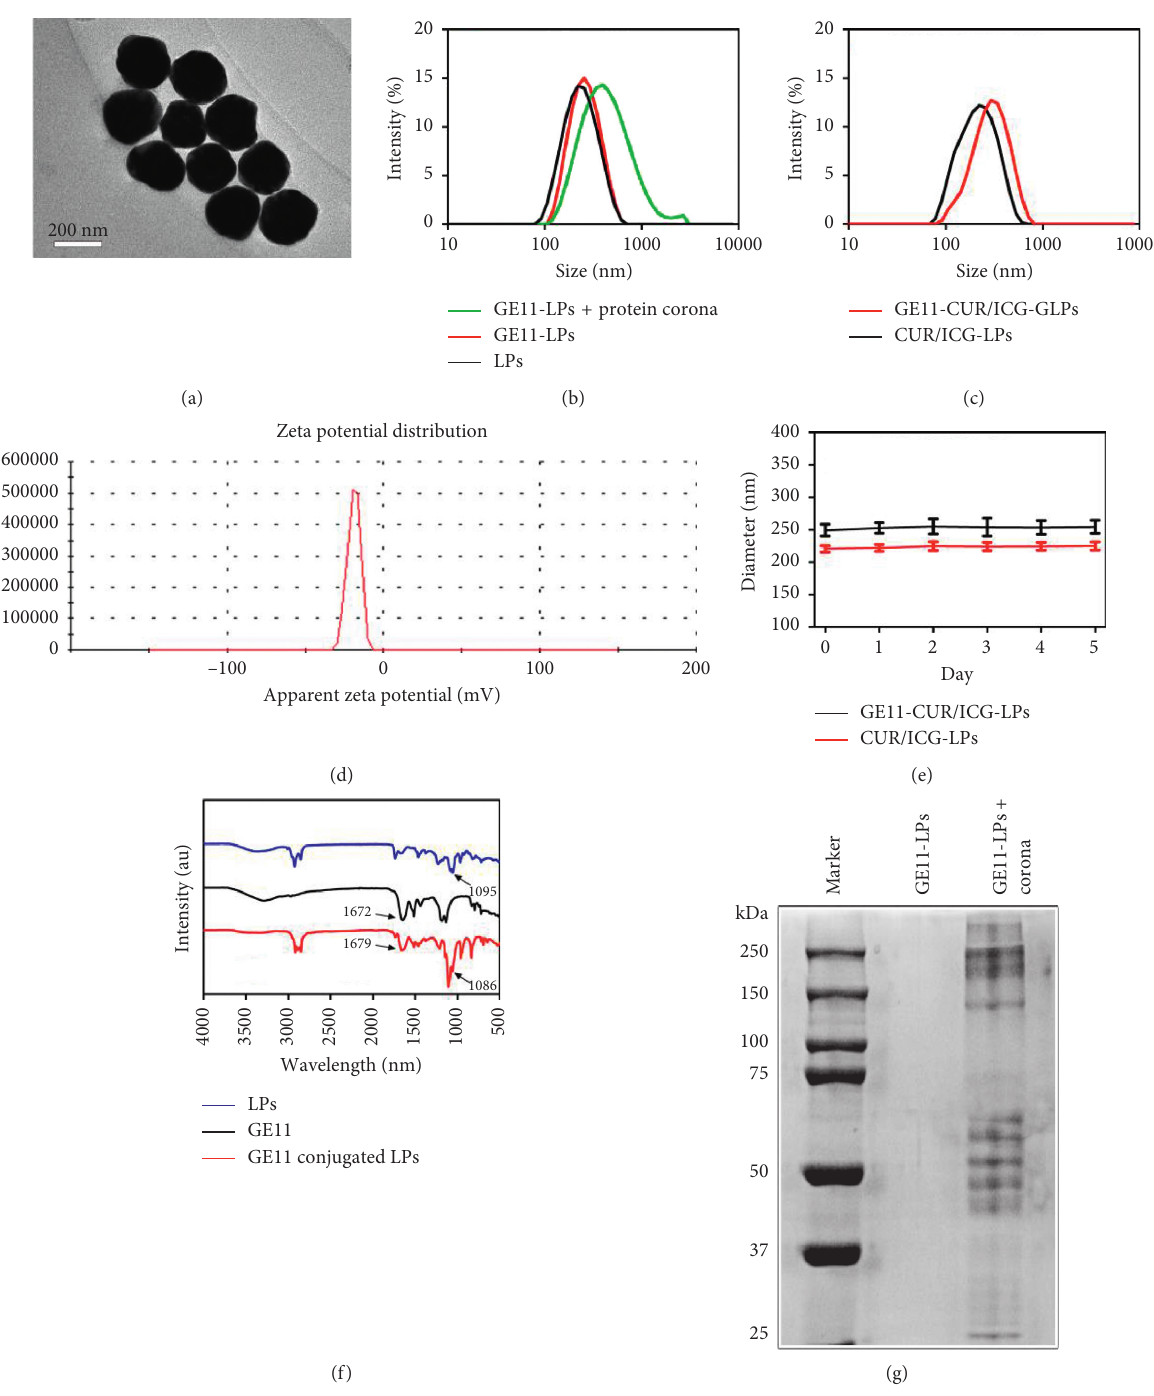
Figure 1: (a) TEM images of GE11-CUR/ICG-LPs. Scale bar � 200 µ m. (b) Size distribution of LPs, GE11-LPs, and GE11-LPs +protein corona. (c) Size distribution of CUR/ICG-LPs and GE11-CUR/ICG-LPs. (d) Zeta potential of GE11-CUR/ICG-LPs. (e) Time-dependent diameter changes of CUR/ICG-LPs and GE11-CUR/ICG-LPs in PBS at 37 ° C. (f) FTIR spectra of LPs, GE11 peptide, and GE11-LPs. (g) Identification of protein corona absorbed on the surface of GE11-LPs by